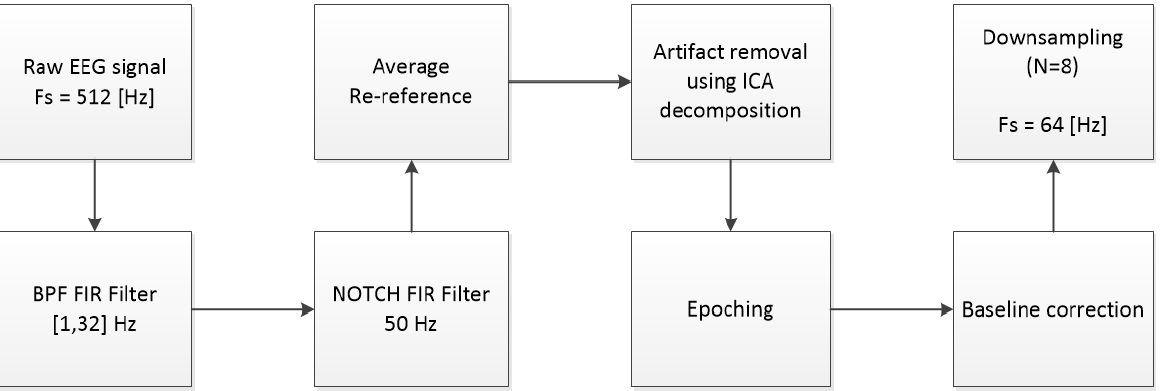
Figure 3. Preprocess pipeline.